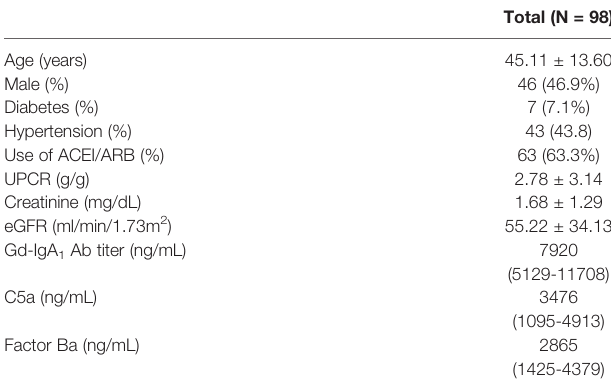
TABLE 1 | Baseline characteristics of all IgAN